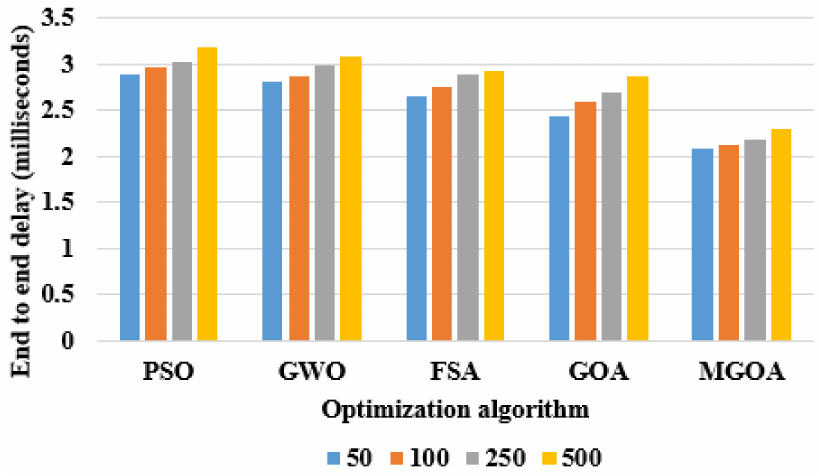
Figure 6. Graphical analysis of MGOA-WAVLCN in terms of end-to-end delay.